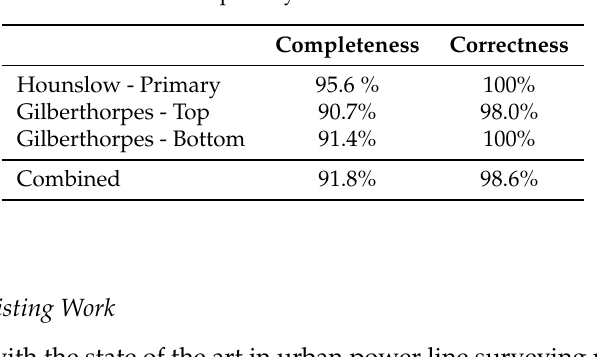
Table 11. Completeness and Correctness for primary conductors in Hounslow and Gilberthorpes